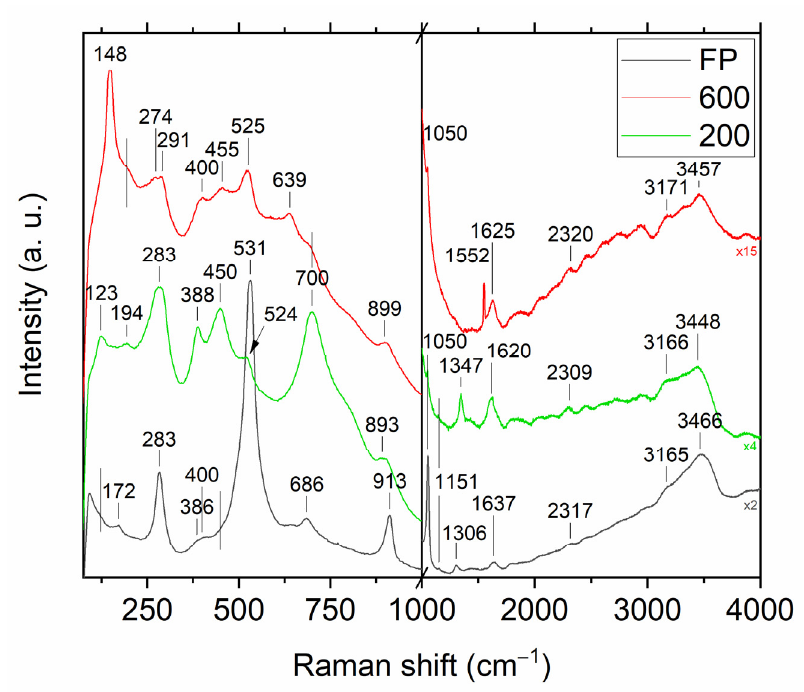
Figure 6. Raman spectra of feedstock powder (black), sample 200 (green) and 600 (red).